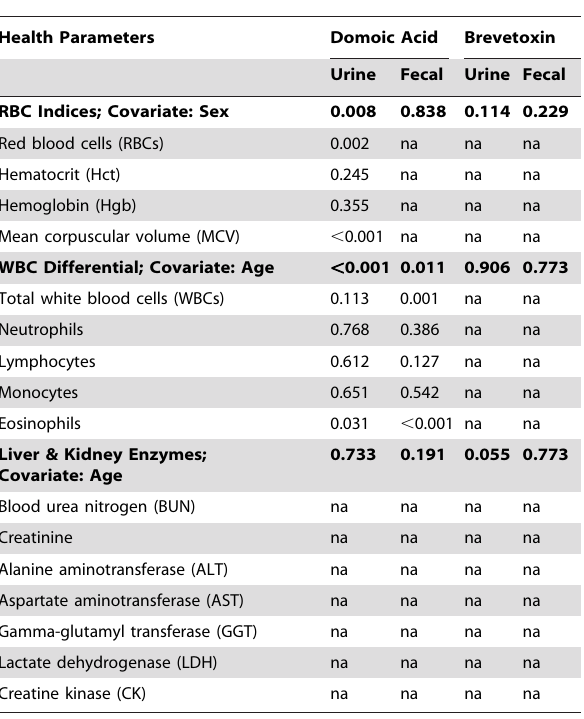
Table 3. Relationships between toxin concentrations and various health parameters examined by p-values generated from generalized linear model (GLM).